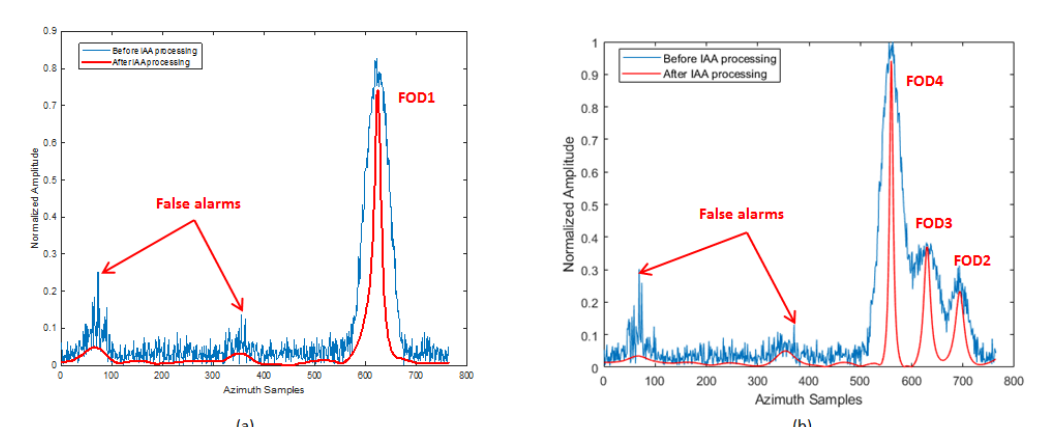
Figure 10. After IAA processing of the area of Scene 1.